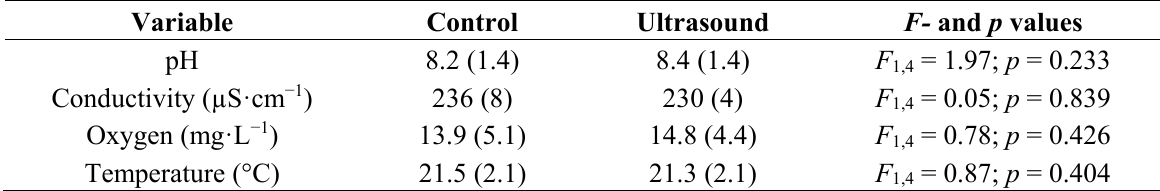
Table 3. Mean values (±1 SD) of water quality variables in 85 L plankton communities kept in the absence (Control) or presence of ultrasound (Ultrasound). Also included are the results ( F- and p values) of the between subject effects from repeated measure